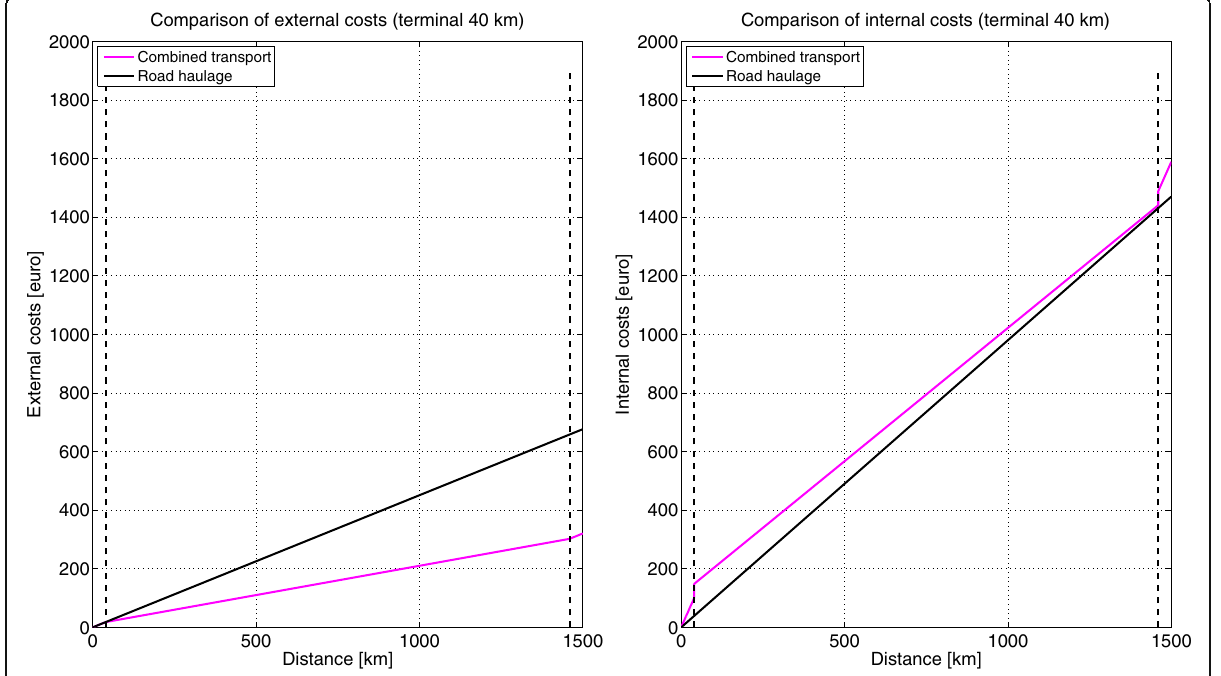
Fig. 8 Comparison of the external and internal costs for the two alternatives (terminal location: 40 km) (related to the transport of one standard ITU 40 ′ )